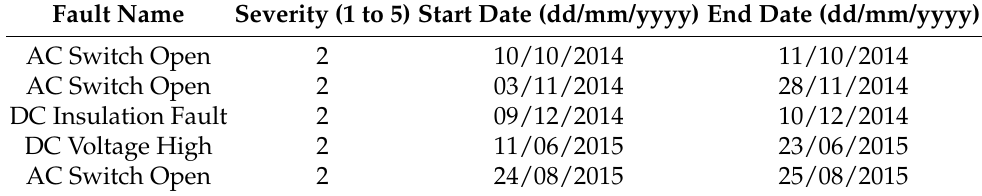
Table 5. Main failures occurred on inverter A.2 of plant A in the historical